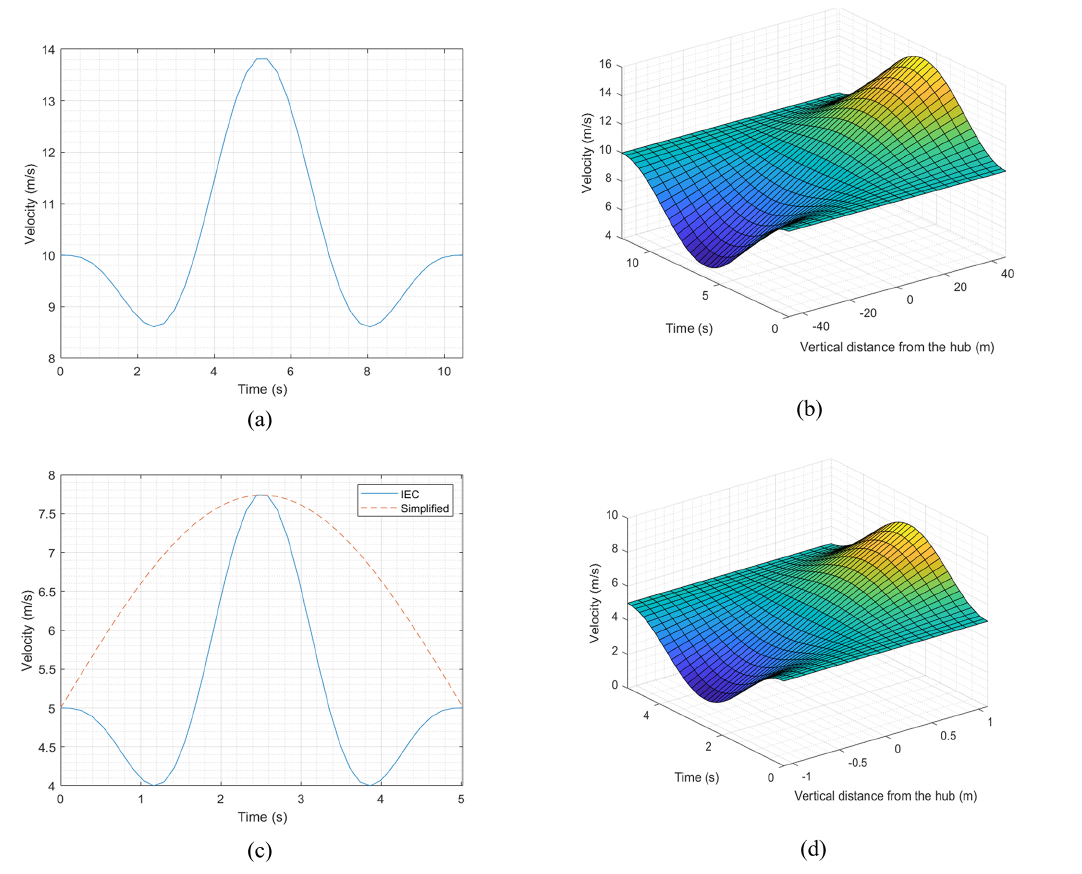
Figure 1. Extreme operational conditions for a full-scale HAWT III B class with 92m diameter and hub height of 80m at 10ms − 1 uniform wind speed, (a) extreme operational gust and (b) extreme vertical shear on the rotor with hub height as reference, The scaled extreme condition, (c) the IEC EOG and the simplified EOG that was targeted, and (d) extreme vertical shear. Adopted from Shirzadeh et al. (2020).